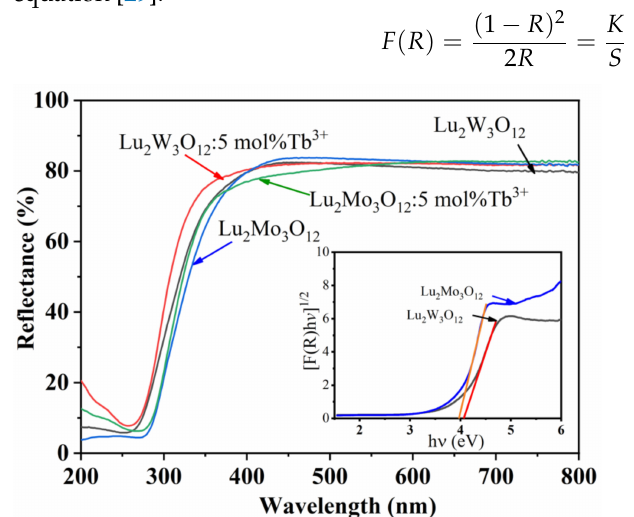
Figure 10. DRS of 5 mol% Tb 3+ -doped and undoped Lu 2 W 3 O 12 and Lu 2 Mo 3 O 12 materials. Inserts display [F(R)h ν ] 1/2 -h ν plots of undoped Lu 2 W 3 O 12 and Lu 2 Mo 3 O 12 samples prepared at 1000 ◦